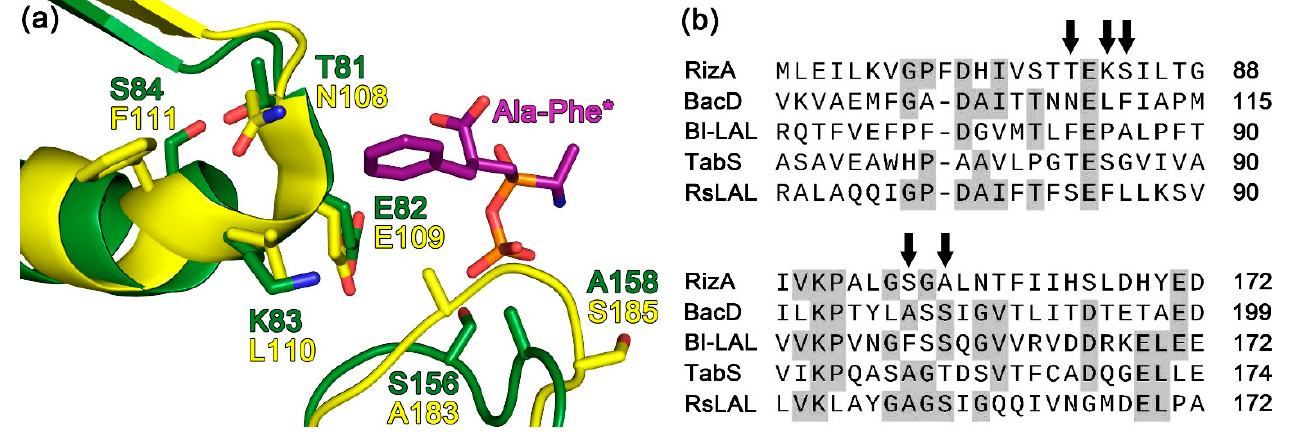
Figure 2. Residues in the C-terminal binding pocket. ( a ) Structural alignment of RizA (green; PDB ID: 4wd3) with BacD (yellow; PDB ID: 3vmm) containing Ala-Phe analog (purple). The structures were displayed using PyMOL [29]. ( b ) Sequence alignment of RizA with other LALs. Arrows indicate positions that were mutated in RizA. Grey highlighting indicates conservation above